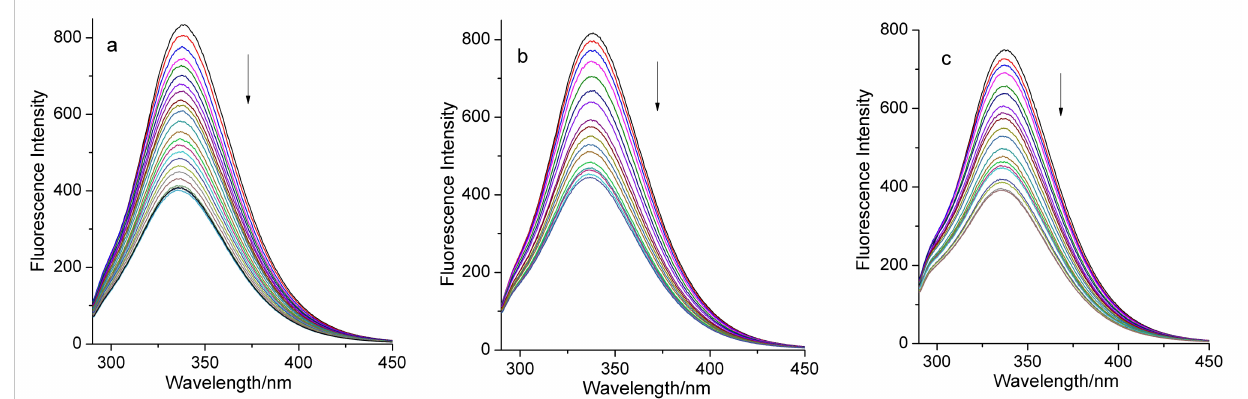
Figure 4. The quenching effect of complex 2 on BSA fluorescence at 298 K ( a ), 308 K ( b ), and 313 K ( c ). The arrows show the emission intensity changes upon the increasing concentration of complex 2